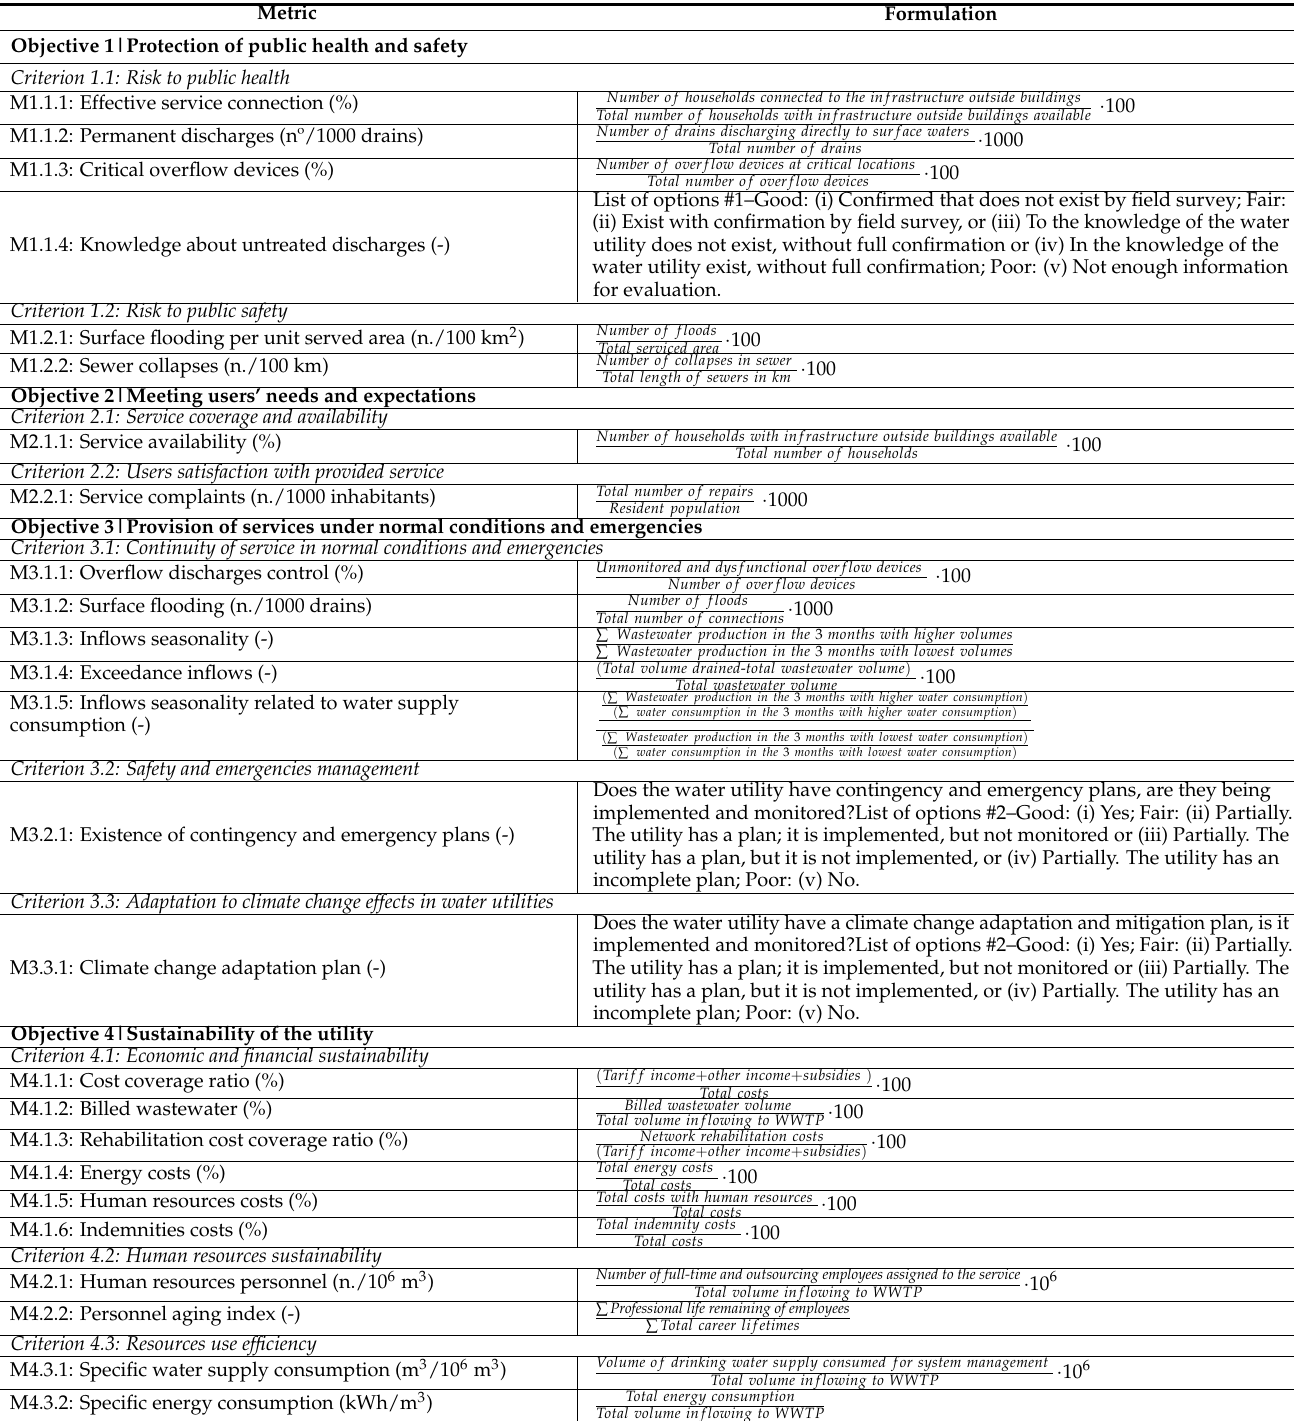
Table A1. Complete metrics description and